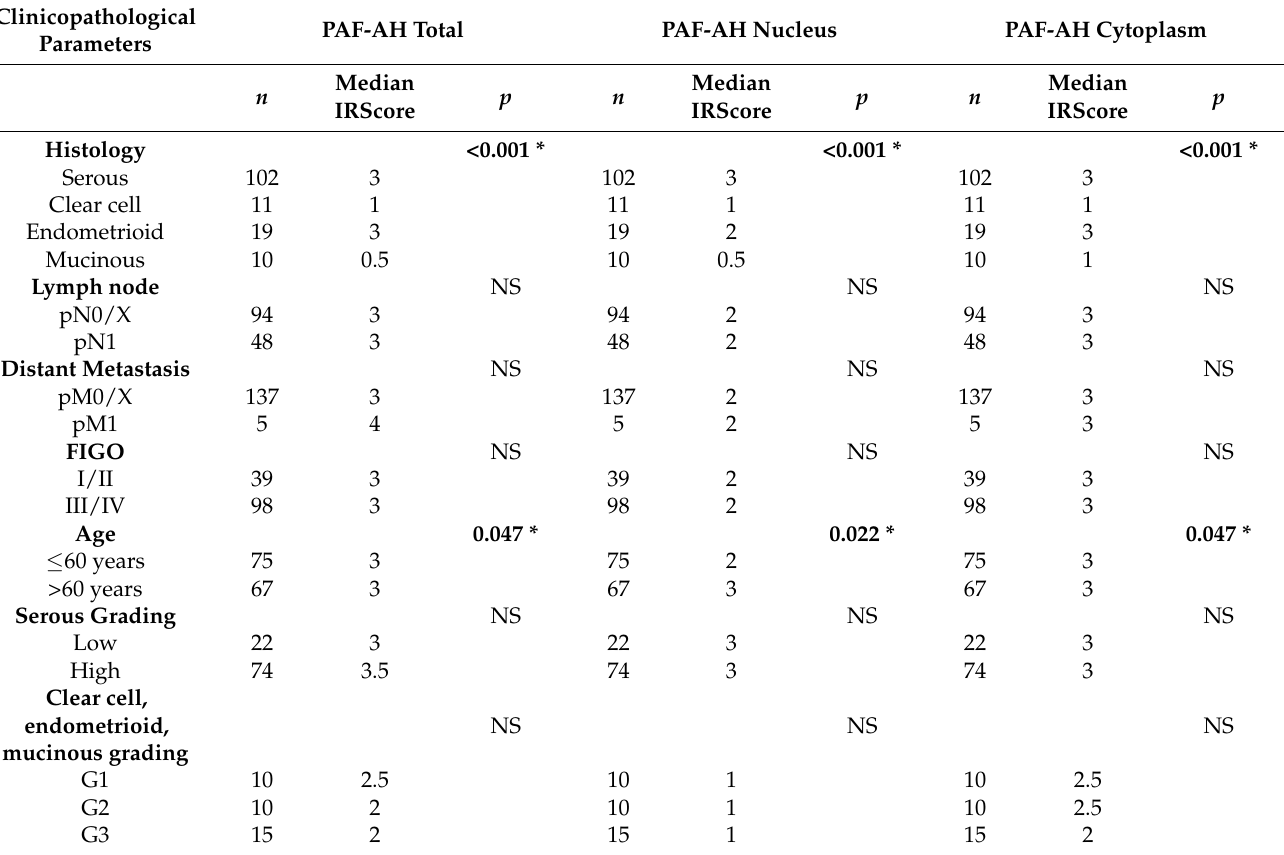
Table 3. Expression profile of PAF-AH regarding clinical and pathological